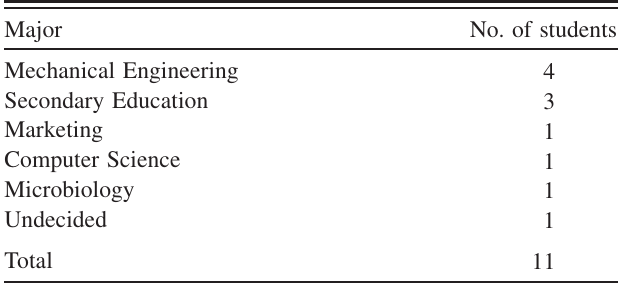
TABLE I. The interviewees as per their